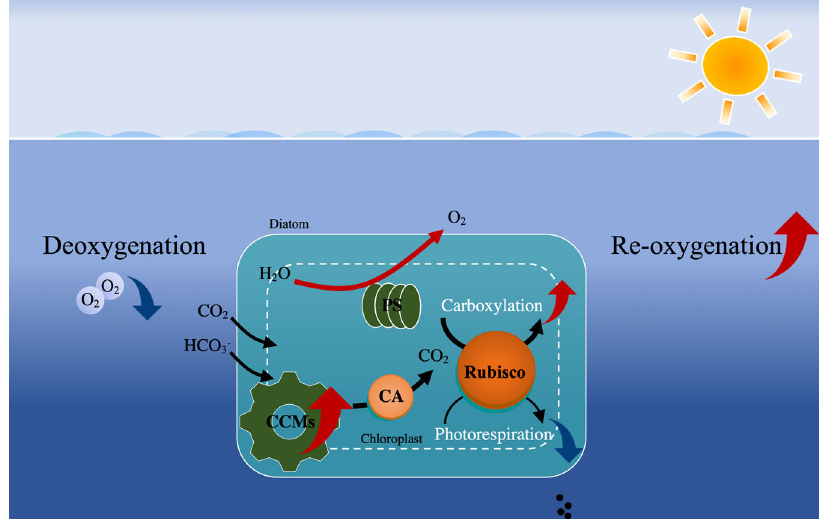
Fig. 7 Simpli fi ed illustration of low O 2 -enhanced CCMs activity and subsequently increased re-oxygenation due to global deoxygenation and/or in intruded hypoxic waters. Reduced O 2 levels enhance CO 2 concentrating mechanisms (CCMs) and photosynthetic performance with increased light energy use ef fi ciency in diatoms and phytoplankton assemblages (Figs. 2 – 6), promoting photosynthetic carbon fi xation and O 2 evolution. The enhanced photosynthesis and reduced mitochondrial and photorespiration (Figs. 5 and 6) can accelerate the re-oxygenation due to stimulated photosynthetic O 2 evolution by up to 193 – 250% (based on net photosynthetic values of day 5 in Fig. 2 assuming that the photosynthetic quotient is 1.0). In